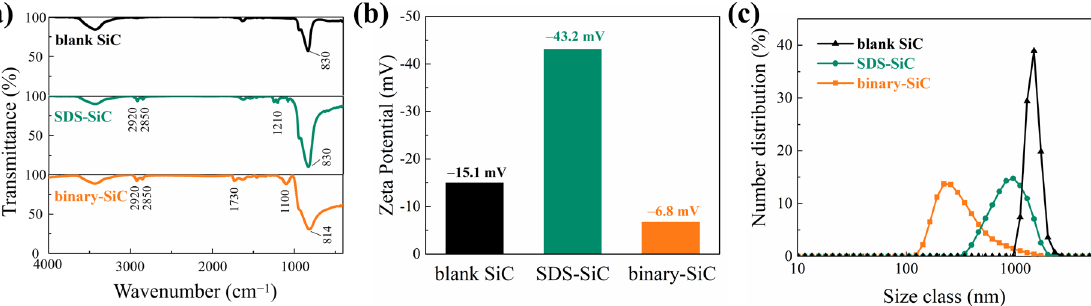
Figure 2. ( a ) Fourier - transform infrared spectra, ( b ) zeta potential, and ( c ) particle size distribution of blank SiC, SDS - SiC and binary - SiC .